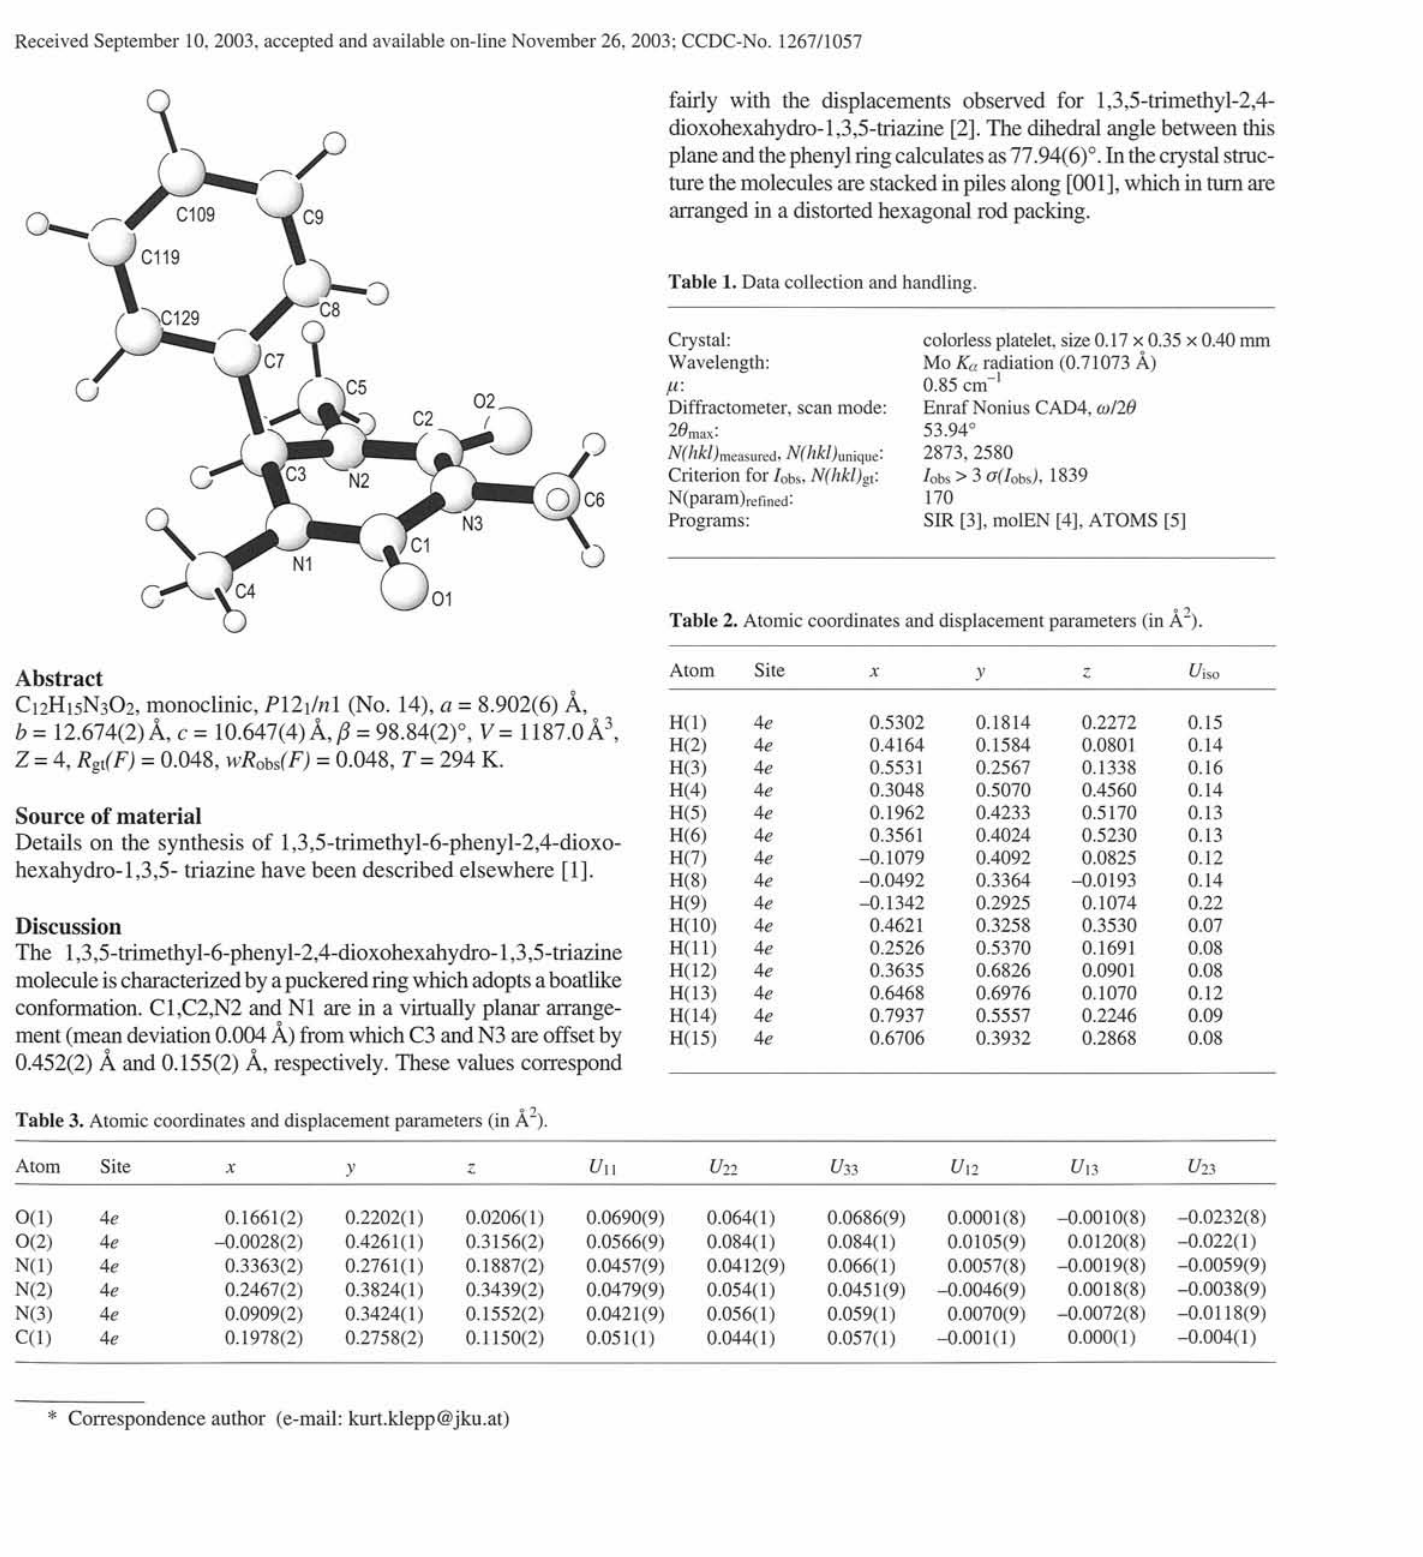
Table 2. Atomic coordinates and displacement parameters (in À 2